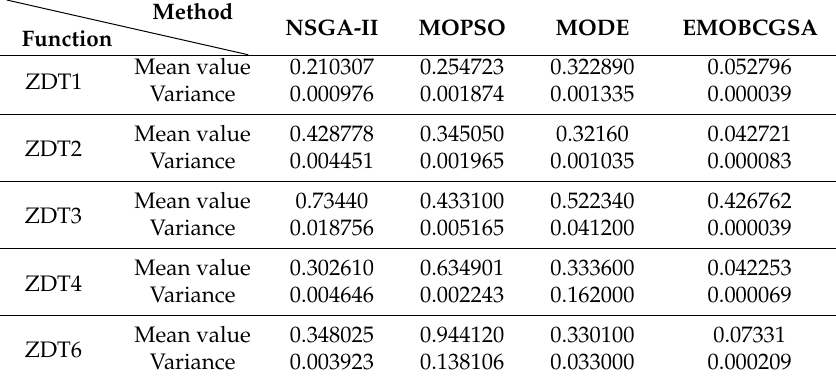
Table 2. Diversity